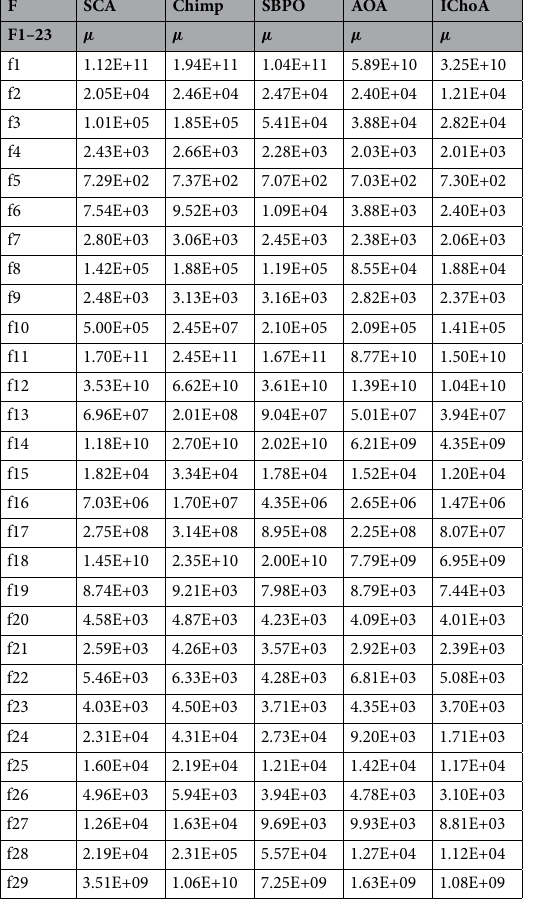
Table 3. Statistical best ( µ ) solutions of algorithms on the 29-CEC’2017 standard test